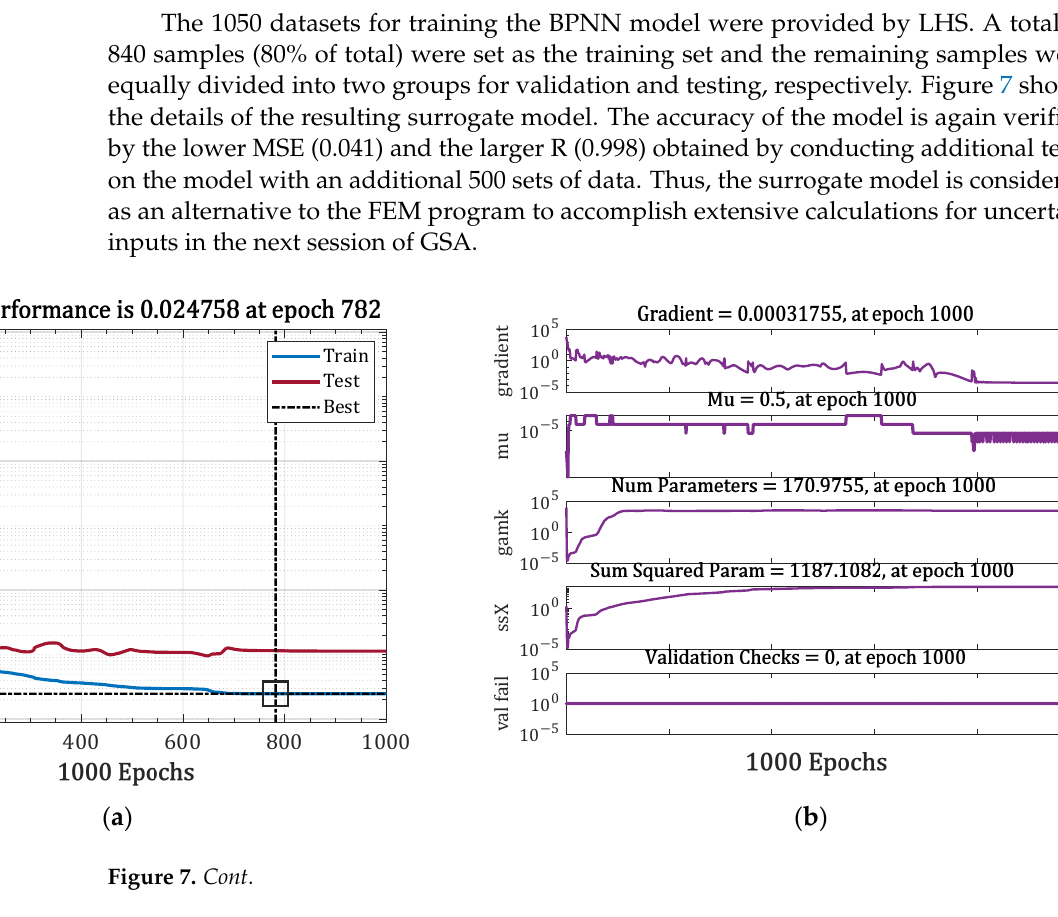
Figure 6. Verification based on Spearman correlation coefficient of parameter irrelevance for evalu- ating Sobol’ indices.